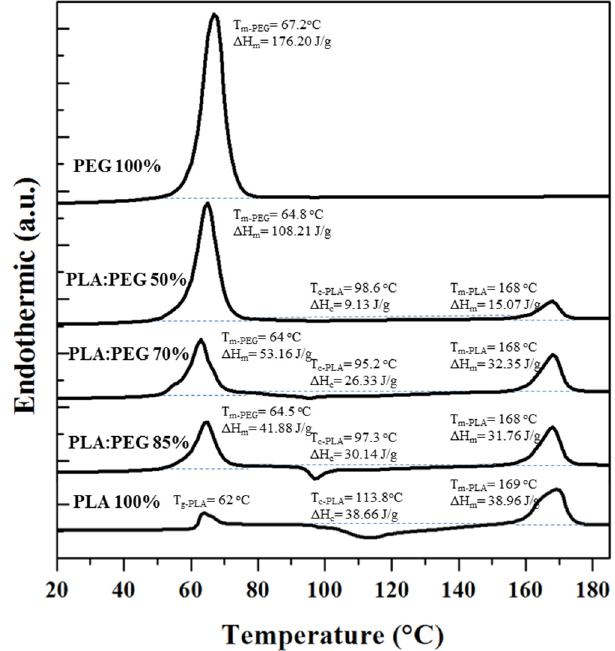
Figure 8. DSC curves corresponding to the first heating scan (10 °C/min) of PEG (top), PLA (bottom) and PLA:PEG blends having the indicated theoretical concentrations.